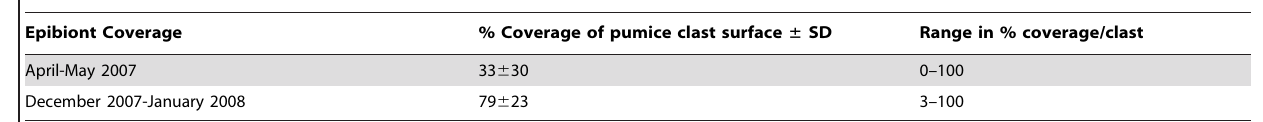
Table 5. Summary of epibiont taxa, their designated feeding guild and their averaged frequency of occurrence.